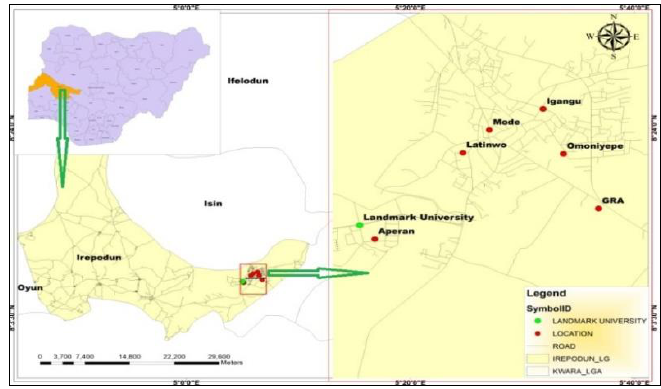
Figure 2: Map of the study